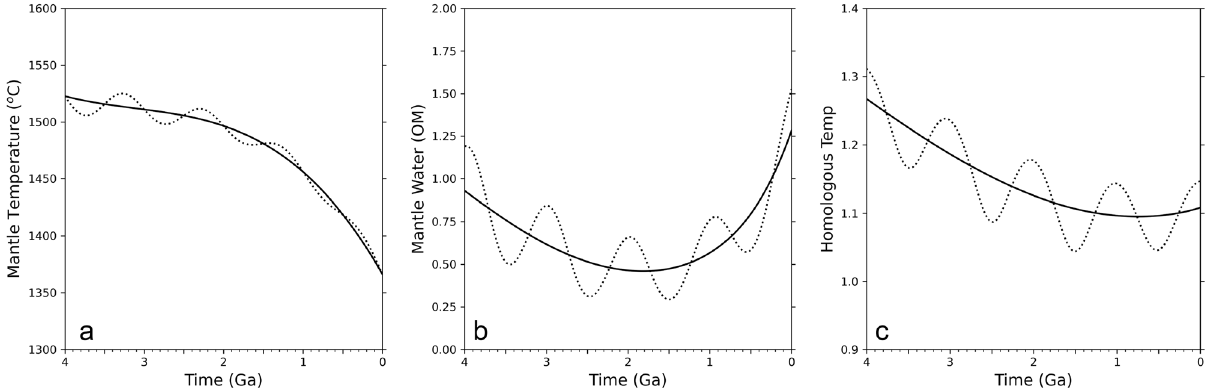
Fig. 6 Analysis of fl uctuations on modeling results. Fluctuations in Earth ’ s potential temperature ( a ) produce an offsetting fl uctuation in mantle water content ( b ). The combined effect is a fl uctuating, but quasi-regulated, homologous temperature (